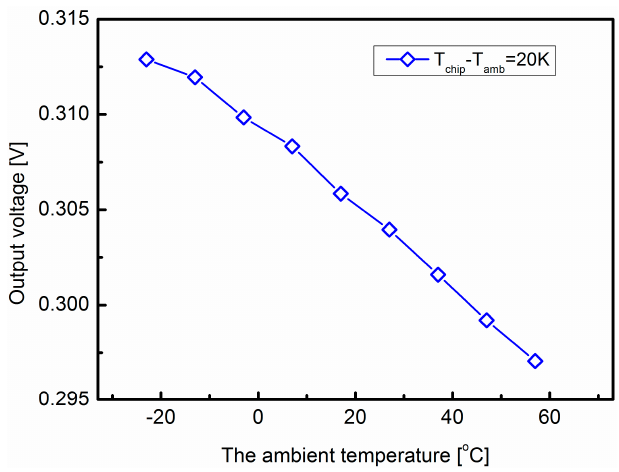
Figure 5. Simulation results of the effect of the thermophysical properties of the airflow on the output voltage at different temperatures.